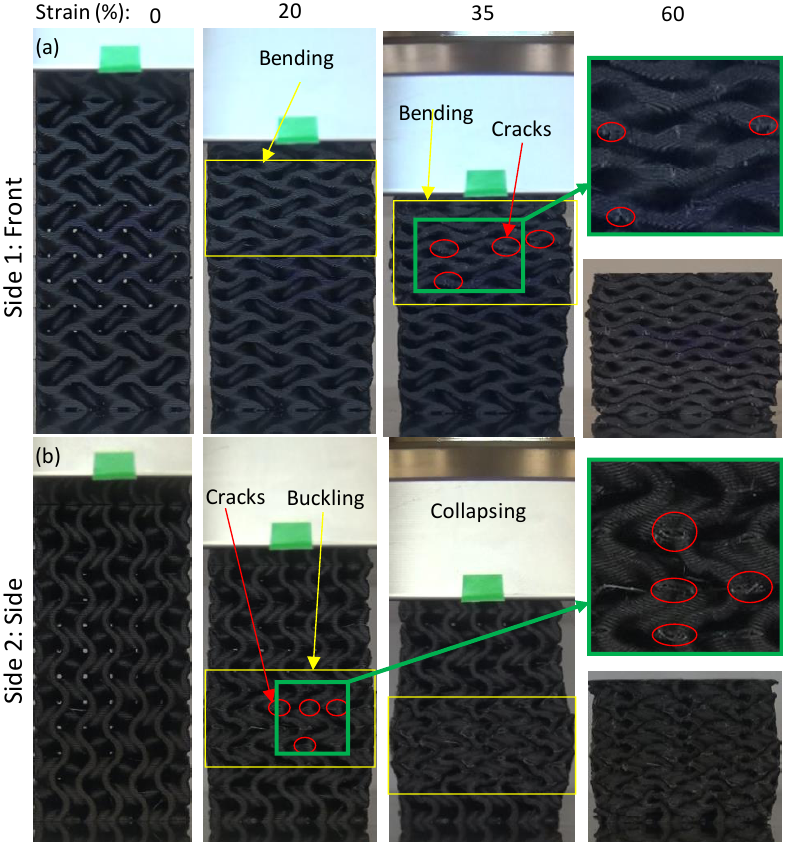
Figure 14. Typical deformation features of Gyroid structure (G-8-44 as an example) on two different sides: ( a ) front and ( b ) side.